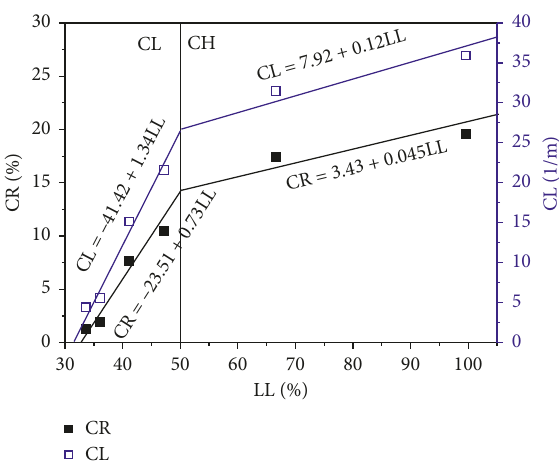
Figure 3: Relationship between CCL crack parameters and soil LL.